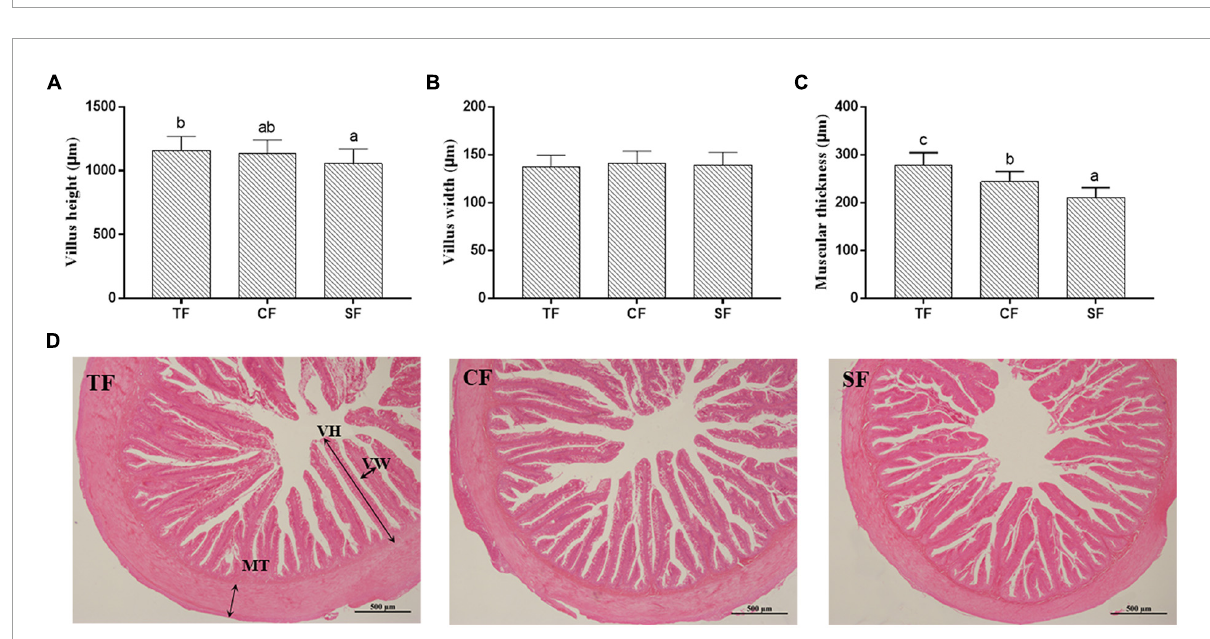
FIGURE2 The intestinal structure of largemouth bass fed trash fish and formula. Values are means ± SD ( n = 3) of three replicates. Bars with different letters denote significant difference among treatments ( P < 0.05). ( A–C ) Muscle fiber density (cell/mm 2 ), Muscle fiber diameter ( µ m), Muscle